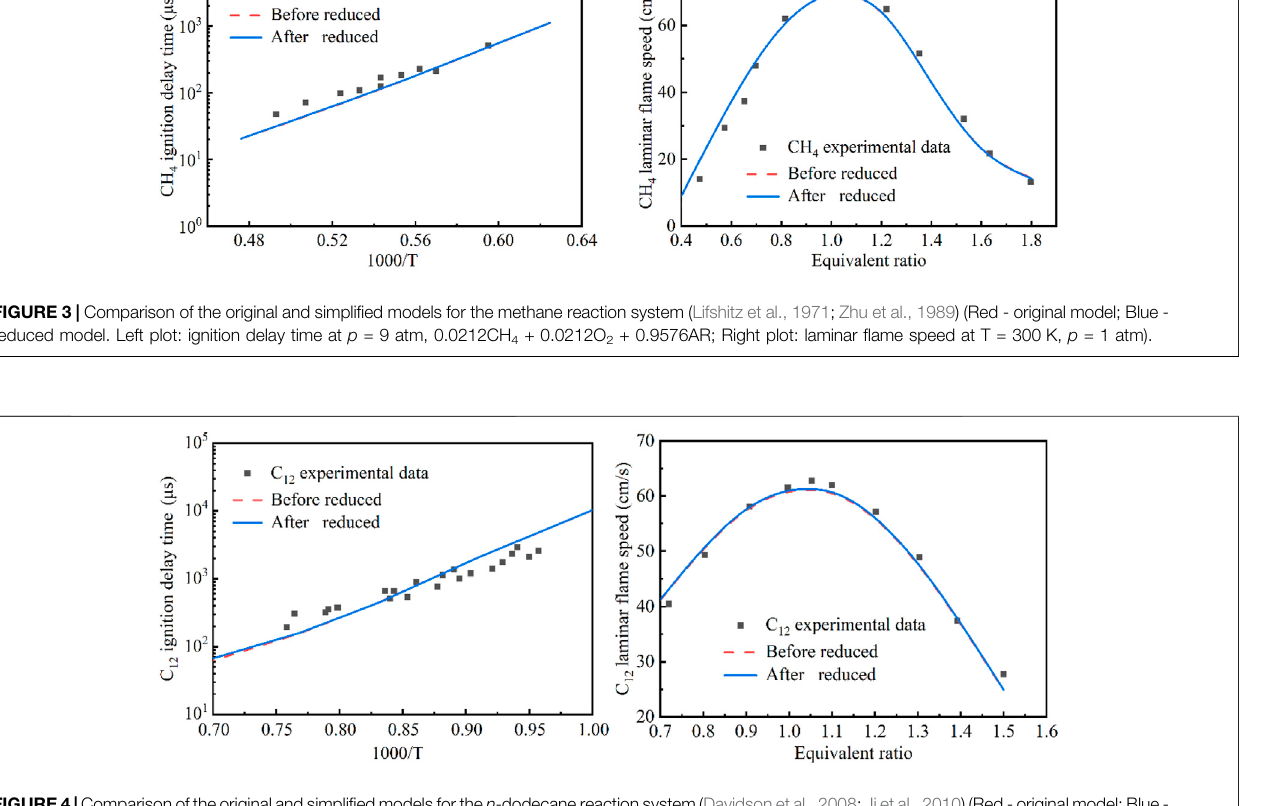
FIGURE4| Comparisonoftheoriginalandsimpli fi edmodelsforthe n -dodecanereactionsystem(Davidsonetal.,2008;Jietal.,2010)(Red-originalmodel;Blue- reduced model. Left plot: ignition delay time at p (cid:2) 6.7 atm, n -C 12 H 26 /21%O 2 + AR, ϕ (cid:2) 0.5; Right plot: laminar fl ame speed at T (cid:2) 403 K, p (cid:2) 1 atm).